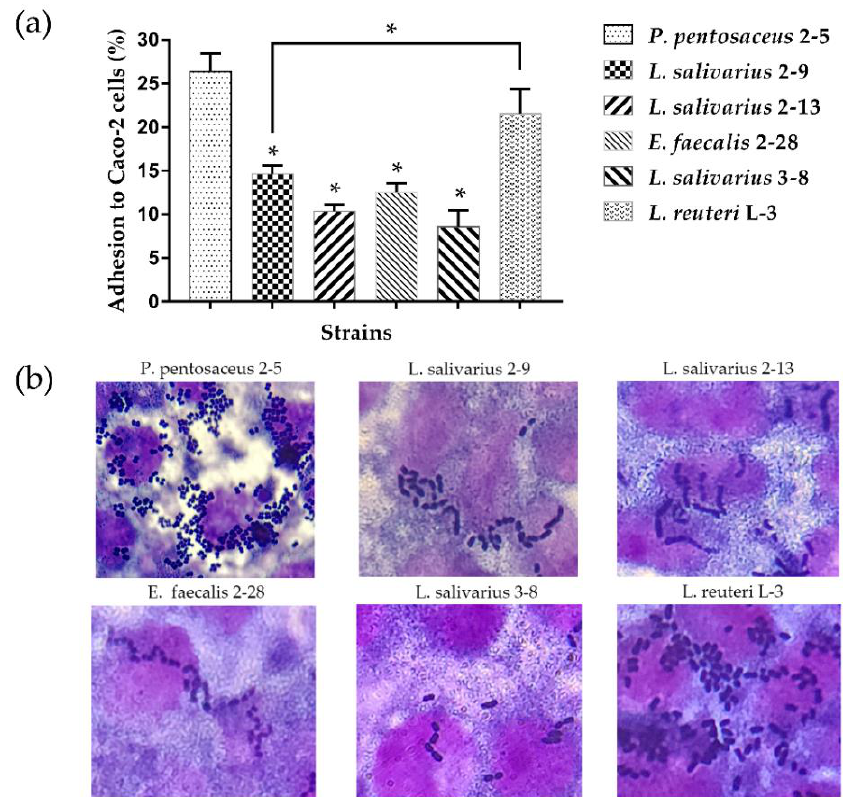
Figure 4. Strains adherence to Caco-2 cells: ( a ) Percentage of strains adherence to Caco-2 cells. ( b ) Representative microscopic observation (1000×). The results represent the mean ± SD of three independent experiments. The significant difference was indicated by asterisks compared to P. pentosaceus 2-5: * p <0.05.